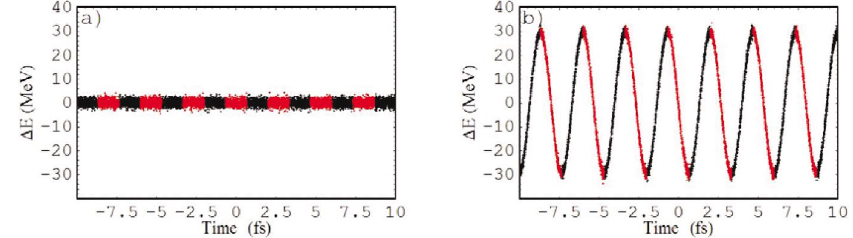
FIG. 3. (Color) The electron beam energy distribution before (a) and after (b) the wiggler. Color coded are equal length regions (red) and z (cid:1) (cid:17)(cid:7) n (cid:2) 0 : 5 (cid:8) (cid:1) (black). Only a short section of the electron beam is actually shown. centered at z (cid:1) (cid:17) n(cid:1) L L